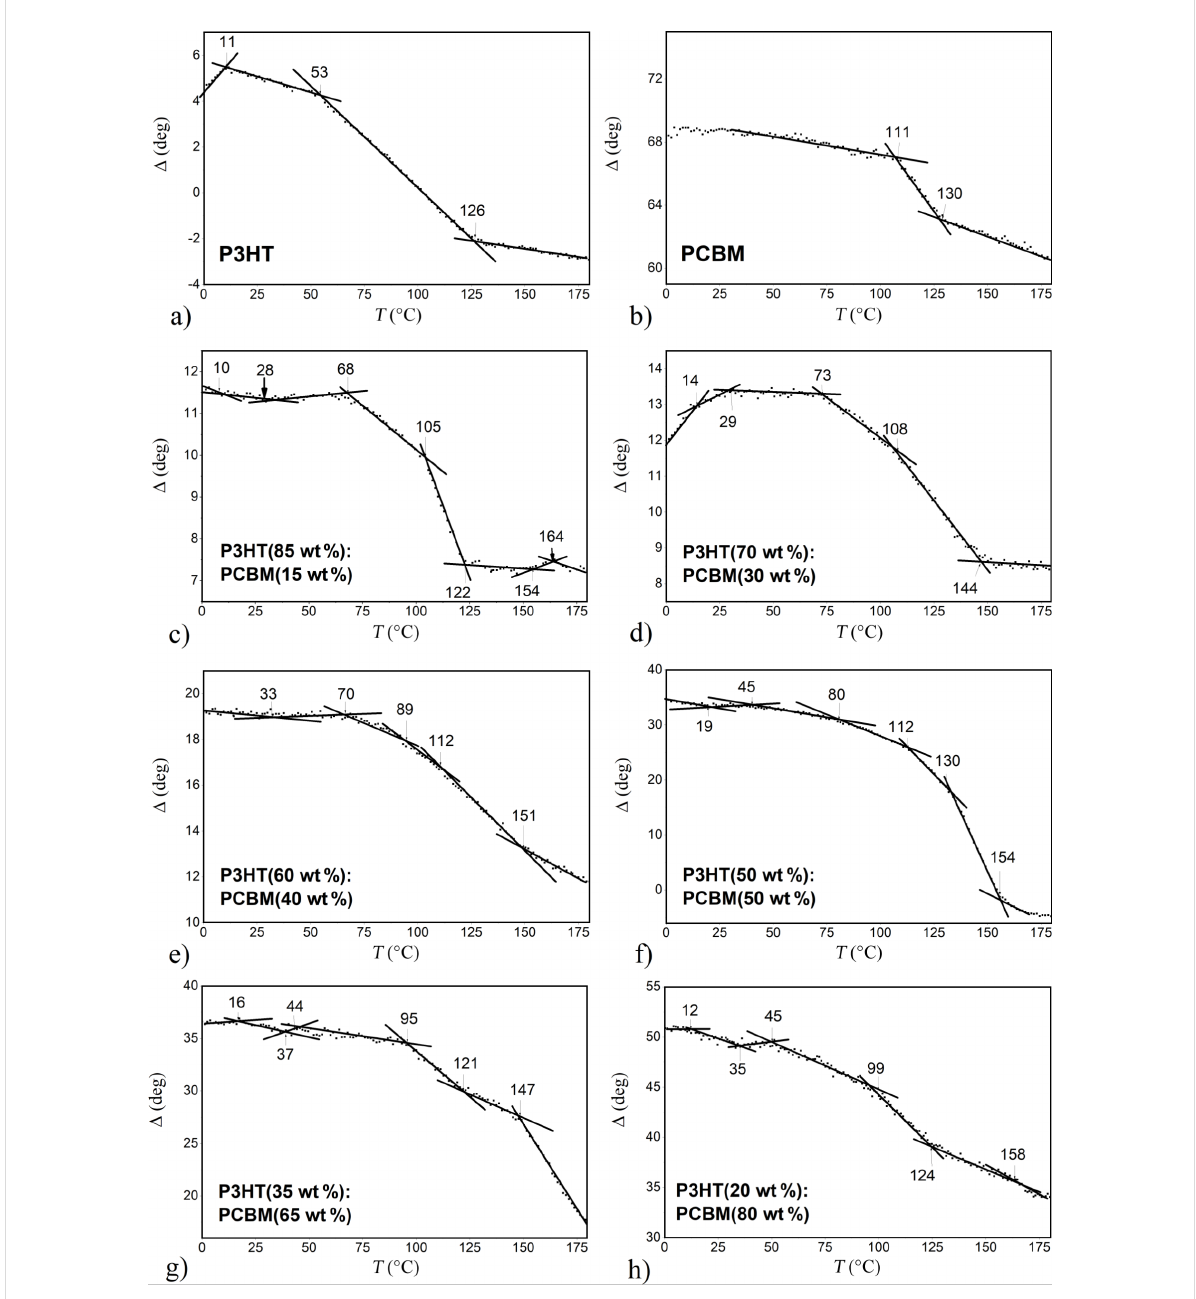
Figure 4: Δ at 280 nm as a function of temperature for P3HT:PCBM blend films with different polymer contents: a) P3HT, b) PCBM, c) 15, d) 30, e) 40, f) 50, g) 65 and h) 80 wt % PCBM.